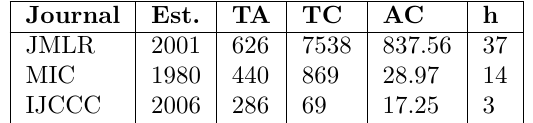
Table 3: Statistics for 3 different OA journals recorded on 17.11.2009. TA is the total number of ar- ticles, TC the total number of citations and AC the average number of citations per